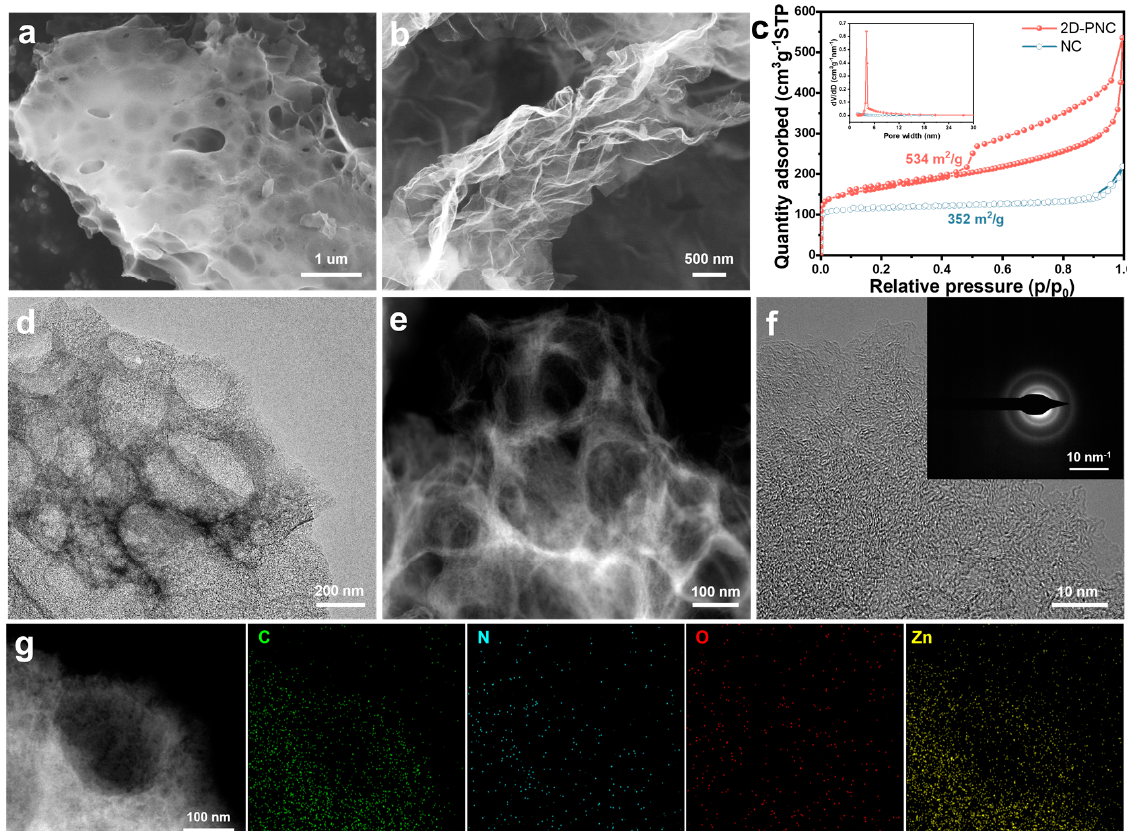
Figure 3. ( a , b ) SEM images of 2D-PNC. ( c ) Nitrogen desorption/adsorption isotherms and pore size–distribution curves of 2D-PNC and NC. ( d , e ) TEM and ( f ) enlarged TEM images with the SAED pattern. ( g ) TEM and related energy-dispersive X-ray (EDX) mapping images of 2D-PNC.